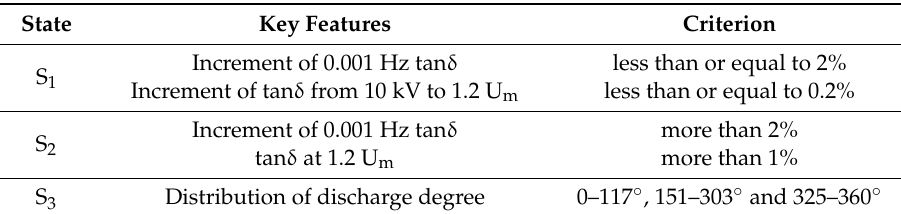
Table 1. Features of Deterioration State